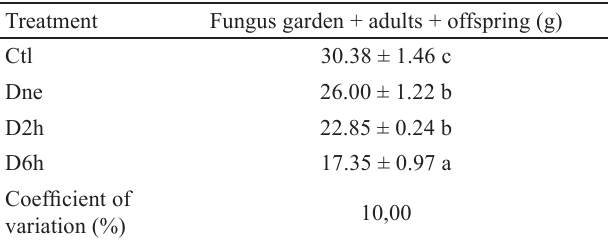
Table 2 . Mass of the fungus of Atta sexdens rubropilosa colonies 21 DAA (days after